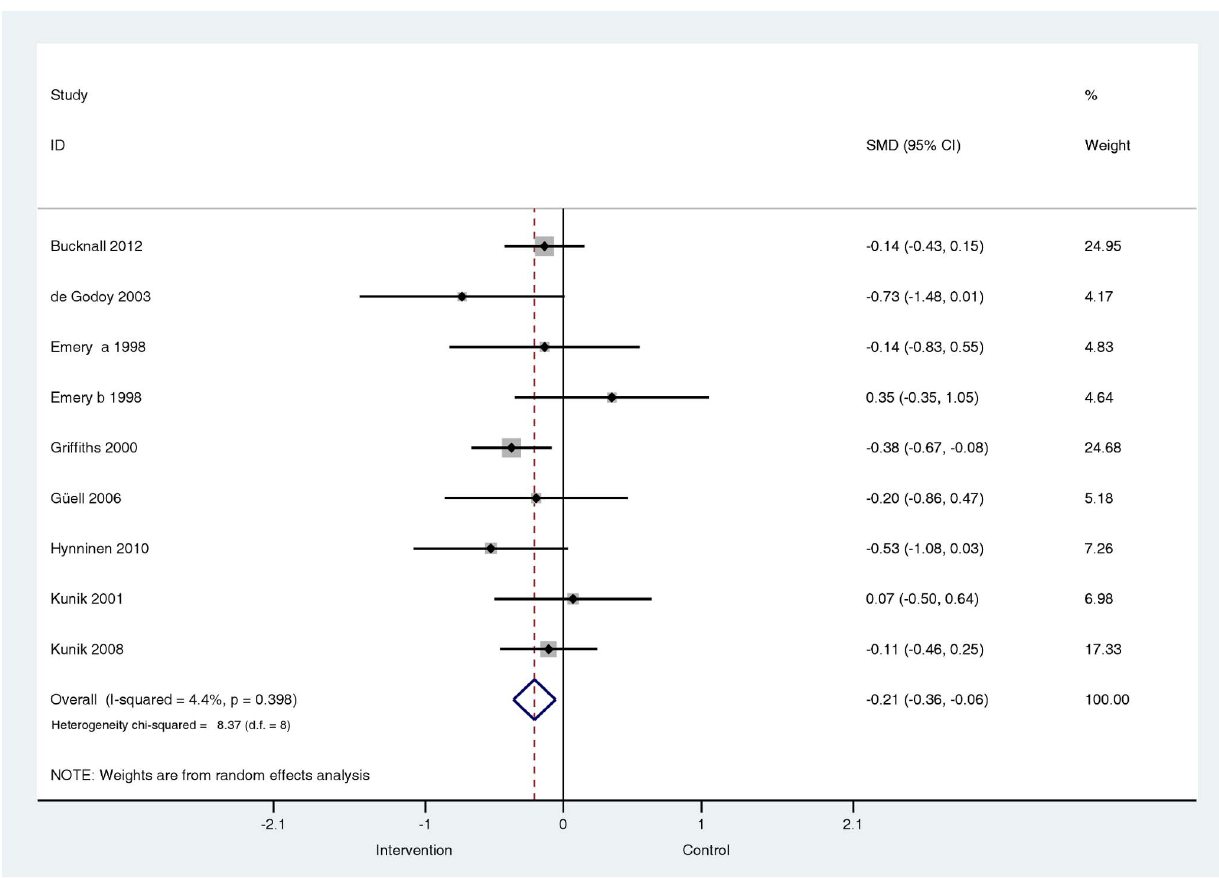
Figure 11. Effects on self-reported symptoms of anxiety in trials that included confirmed anxious samples or above threshold samples. Note: Random effects model used. 95% CI=95% confidence intervals; SMD=standardised mean difference.